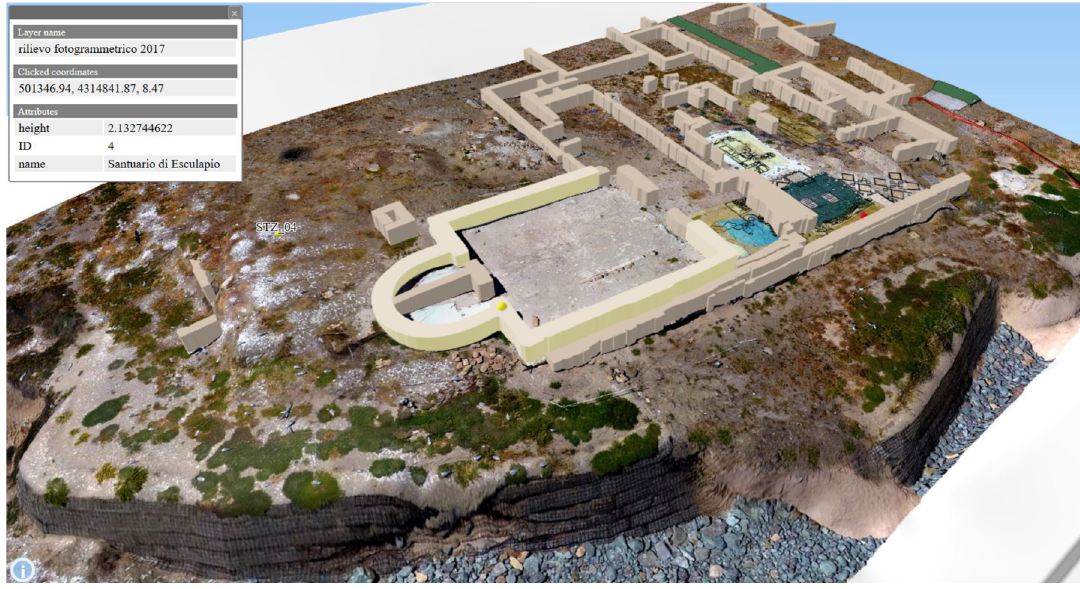
Figure 6. WebGIS page by Qgis2threejs. The plugin’s output in an HTML page preserving height values and attributes for every